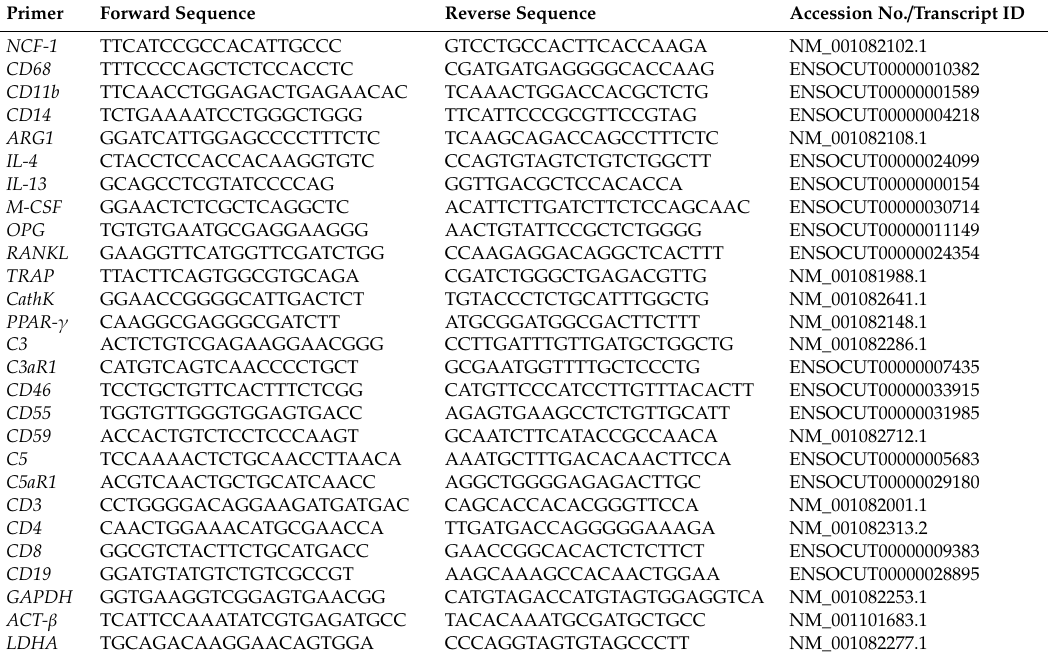
Table 1. Gene sequences.